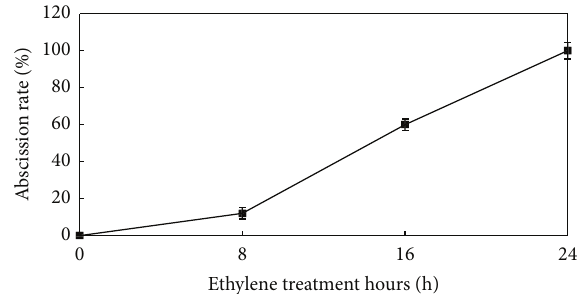
Figure 1: Effect of ethylene on abscission rate of tomato pedicel explants. Vertical bars indicate ± S.E. ( 𝑛 = 3 ).